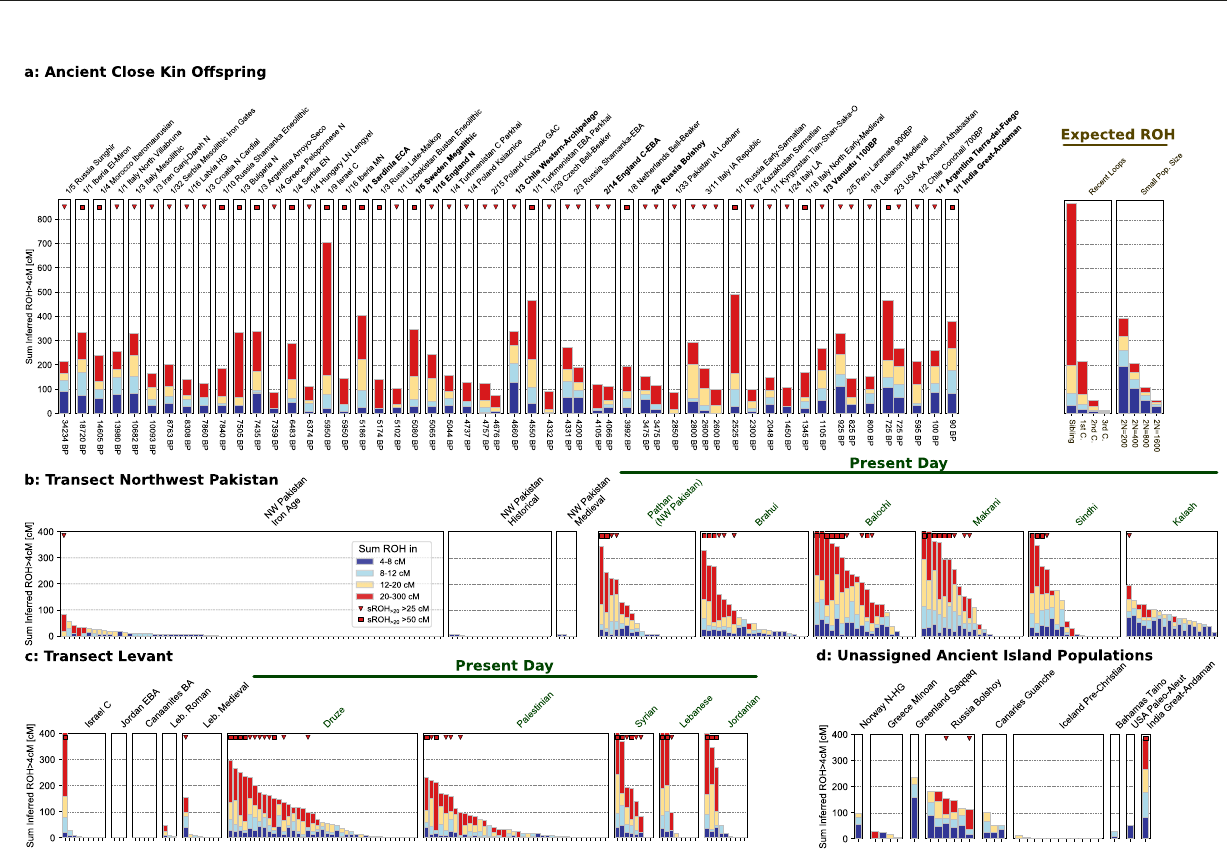
Fig. 2 Time transects of major regions. a Global distribution of ancient individuals screened for ROH. b Global distribution of ancient individuals with long ROH. c – f We plot sROH [4,8] for individuals (represented as circles) within several geographic transects (de fi ned in Table S1). Mean estimates were calculated from a Gaussian Process (GP) model (solid black line, see Section “ Methods ” ), as well as 95% empirical con fi dence intervals for both individuals (light gray) and for the estimated mean (dark gray). Note the square root scale (chosen for GP modeling, see Section “ Methods ” ). Individuals with values larger than the upper y -axis limit are indicated on top of the panels (upward triangles). Horizontal dashed lines depict expectations for sROH [4,8] for panmictic population sizes (see formulas in Supplementary Note 4). In the gray bar at the top of each panel, we indicate individuals with sROH >20 more than 100 (squares) and 50 cM (downward triangles), which are plausibly offspring of close kin (held out when fi tting the GP). Where available, we show ROH in present-day individuals (light-gray points for each individual, violin plot for density estimate).